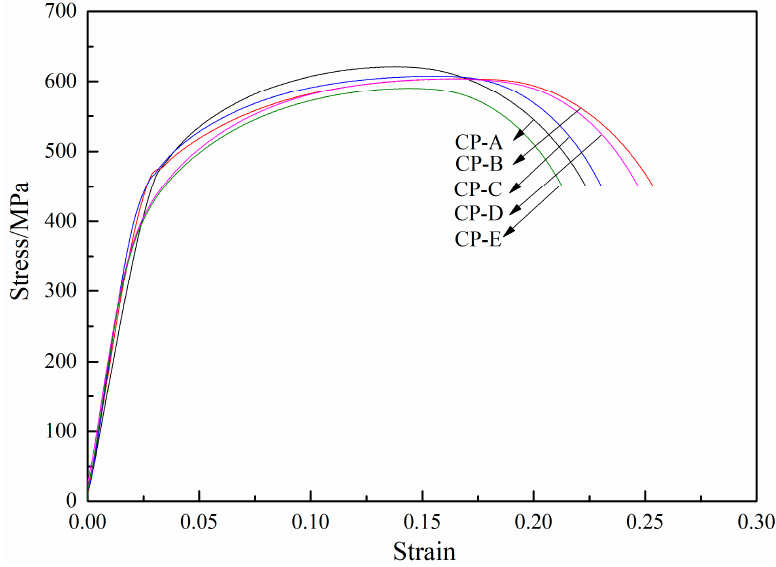
Figure 3. Engineering stress ‐ strain curve for each tensile tested sample with differing CP.